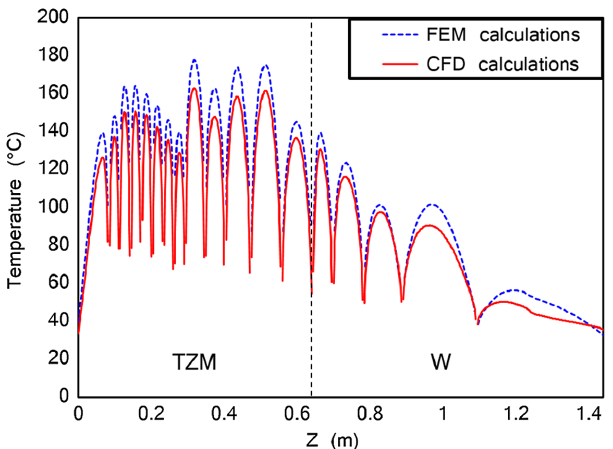
FIG. 12. Temperature profile following a line parallel to the Z-axis and at a distance of 50 mm from the target axis (coincident with the beam impact location). Comparison between FEM and CFD calculations, results obtained at the end of the proton pulse during steady state conditions.